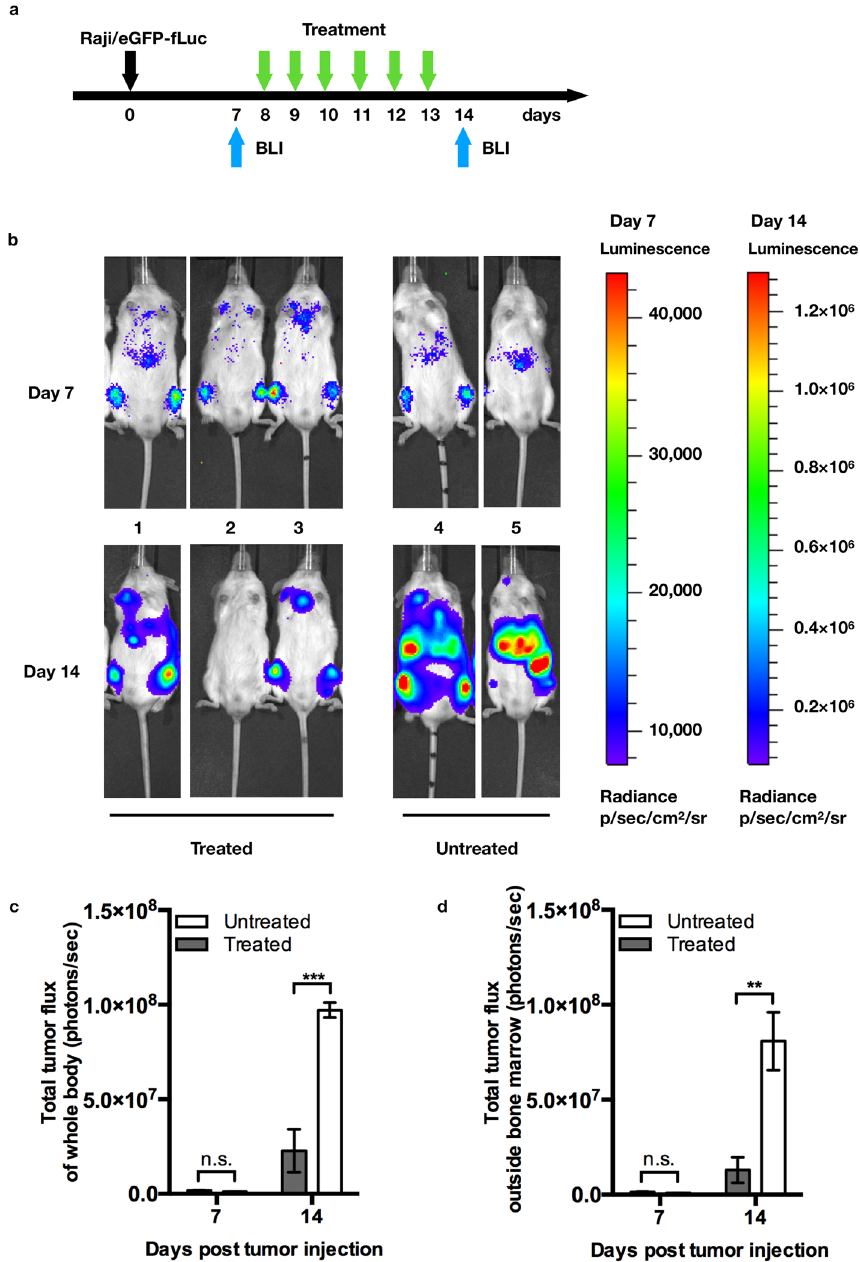
Figure 6. Adoptive transfer of γ9δ2 T cells in combination with CD19BiTE attenuates extramedullary disease. ( a ) Schematic representation of the experimental schedule. Adult NOG mice (40 weeks old, male) were injected with Raji/eGFP-fLuc tumor cells (2.5 × 10 5 cells/mouse) through the lateral tail vein (i.v.). On day eight post tumor injection, mice received daily treatment of two i.v. doses of CD19BiTE (250 ng/dose/mouse) and an i.v. dose of γ9δ2 T cells (2.5 × 10 6 cells/mouse) for six consecutive days (n = 3), or left untreated as controls (n = 2). γ9δ2 T cells were expanded from two donors’ peripheral blood mononuclear cells. A single mouse was treated with the γ9δ2 T cells derived from the same donor at different time points. ( b ) Bioluminescence images (BLI) were taken for each mouse on days 7 and 14 after tumor injection. The total flux (photons/sec) of tumor cells in the whole body ( c ) or the area outside the bone marrow ( d ) was calculated as the sum of bioluminescence signal intensity. Data were plotted as mean ± s.d., and the statistical analysis was performed by two-way analysis of variance (ANOVA) followed by Sidak’s multiple comparison tests (**: p = 0.0011; ***: p = 0.0008; n.s.: not